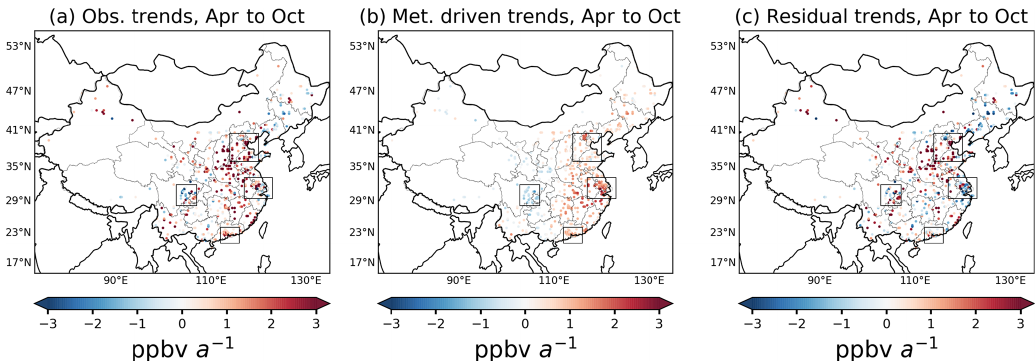
Figure 9. Trends of MDA8 ozone during April–October from 2015–2019. Panel (a) shows the observed trends. Panel (b) shows the me- teorologically driven trends of MDA8 ozone according to RR–2D. Panel (c) shows the trends of residuals (approximating anthropogenic effects). The trends are estimated by the slopes of ordinary linear regressions fitting each year’s April–October MDA8 average ozone values from 2015 to 2019. Table 3. Observational, meteorological and residual trends of regional averaged MDA8 ozone (ppbva − 1 ) from 2015–2019 for both April– October and Northern Hemisphere summertime (June, July, August). Values within the brackets are the p values for each trend. Trends and p values are in bold given p values smaller than